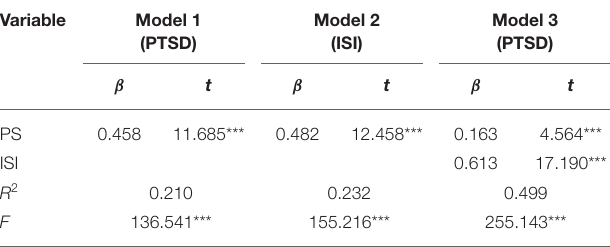
TABLE 3 | Mediated regression analysis for PS and ISI on PTSD.